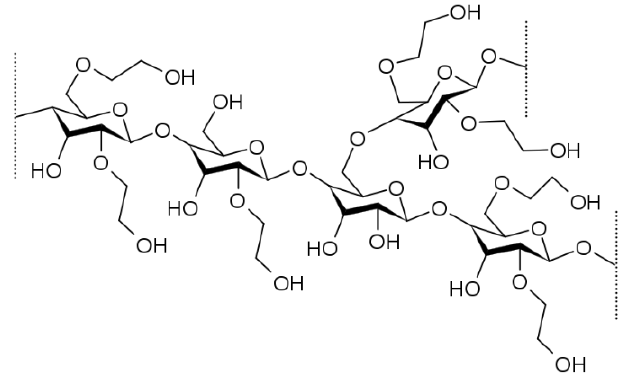
Figure 5. Represents the chemical structure of HEC [49].